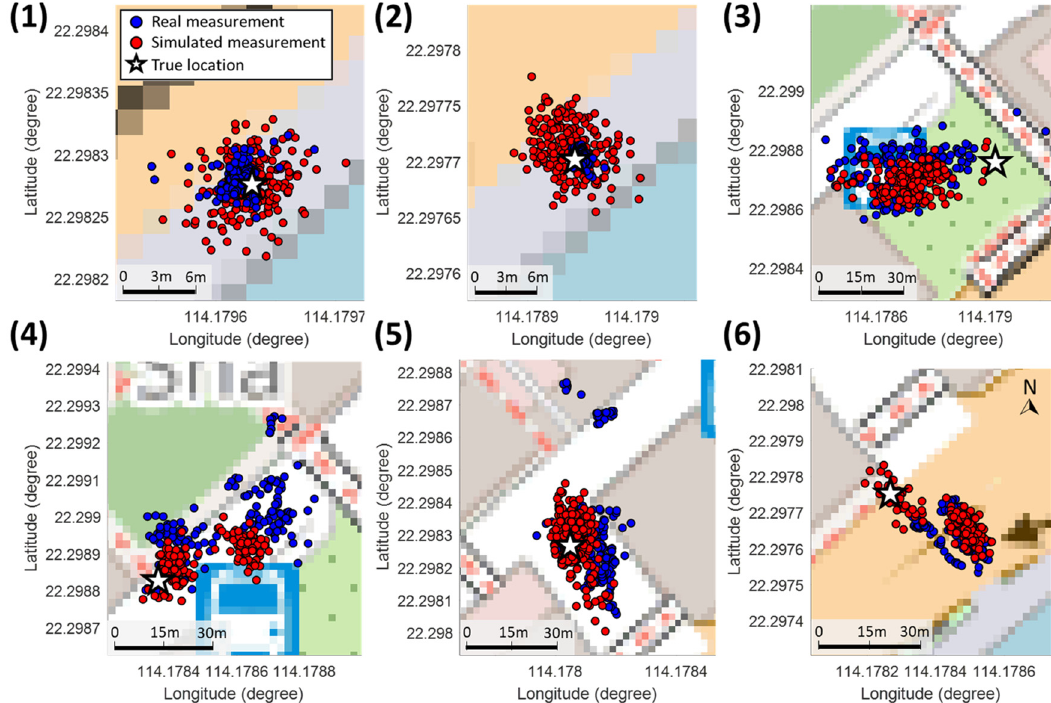
Figure 21. The positioning solutions of different agents based on real measurements (blue) and simulated measurements (red) during the multiagent experiment. The number denotes the agent index corresponding to Figure 10.